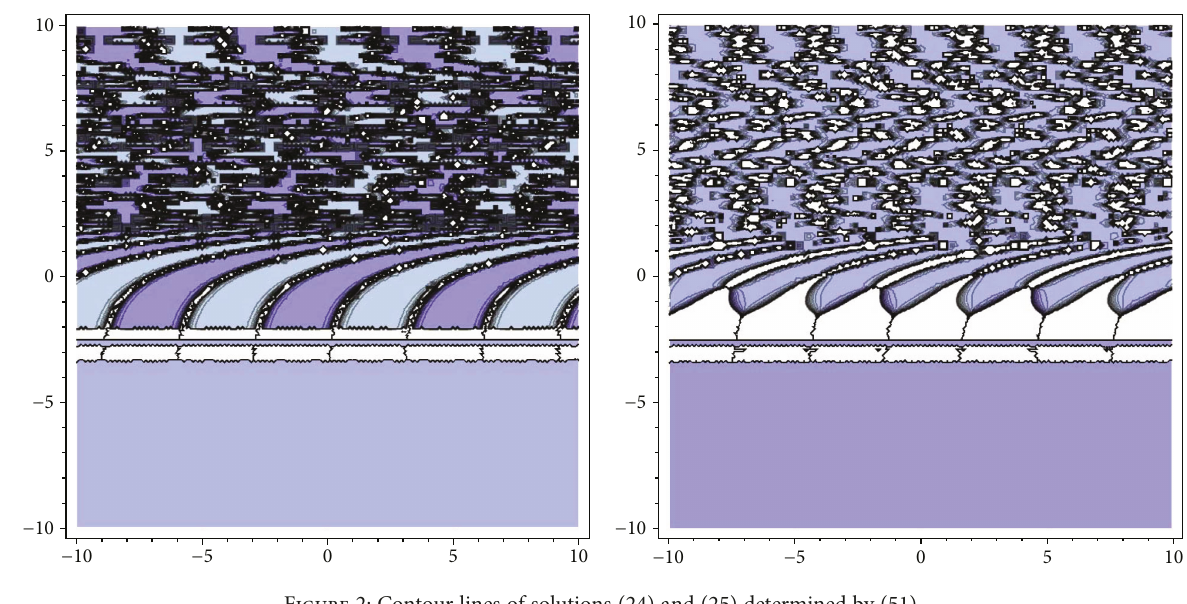
Figure 2: Contour lines of solutions (24) and (25) determined by (51).